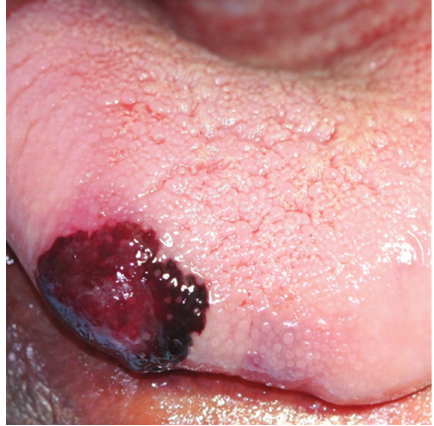
Figure 5: Macular/nodular lesion on the dorsum of the tongue in a 44-year-old female patient with a CD4+ T-cell count of 13cells/mm 3 . The patient died five weeks after the diagnosis of her oral